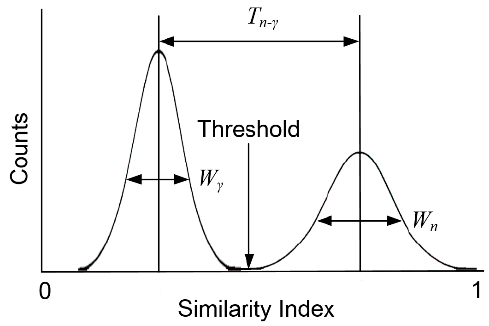
Figure 3. The similarity index distribution (Sample).